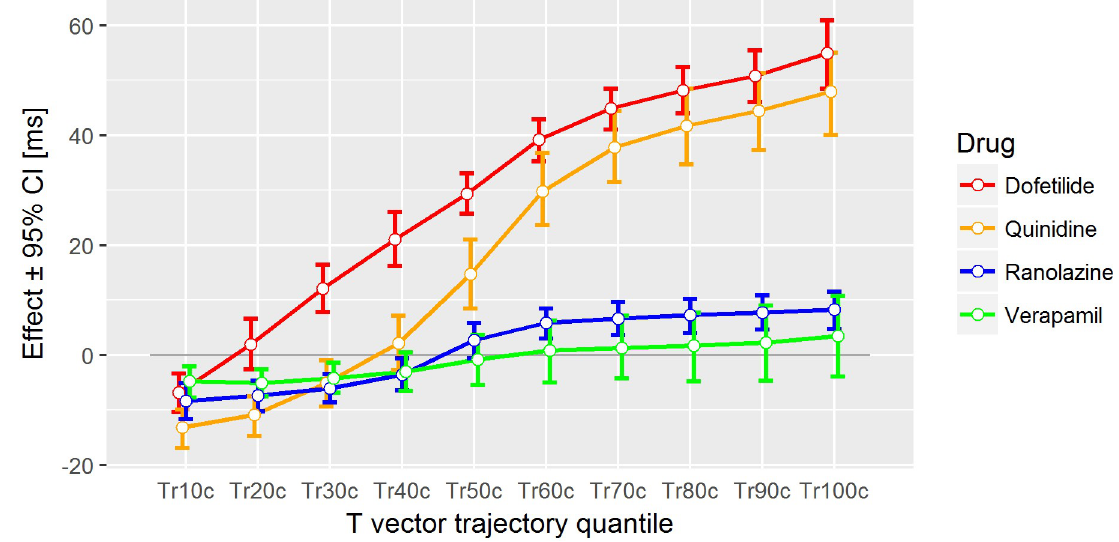
Fig 4. Drug effect profiles in Study A. The effect on the y-axis denotes the placebo-corrected changes from baseline of the T vector trajectory quantiles in milliseconds (corrected for heart rate) with their 95% confidence intervals at the following drug concentrations: dofetilide: 2500 pg/mL, quinidine: 1500 ng/mL, ranolazine: 2000 ng/mL, verapamil: 100